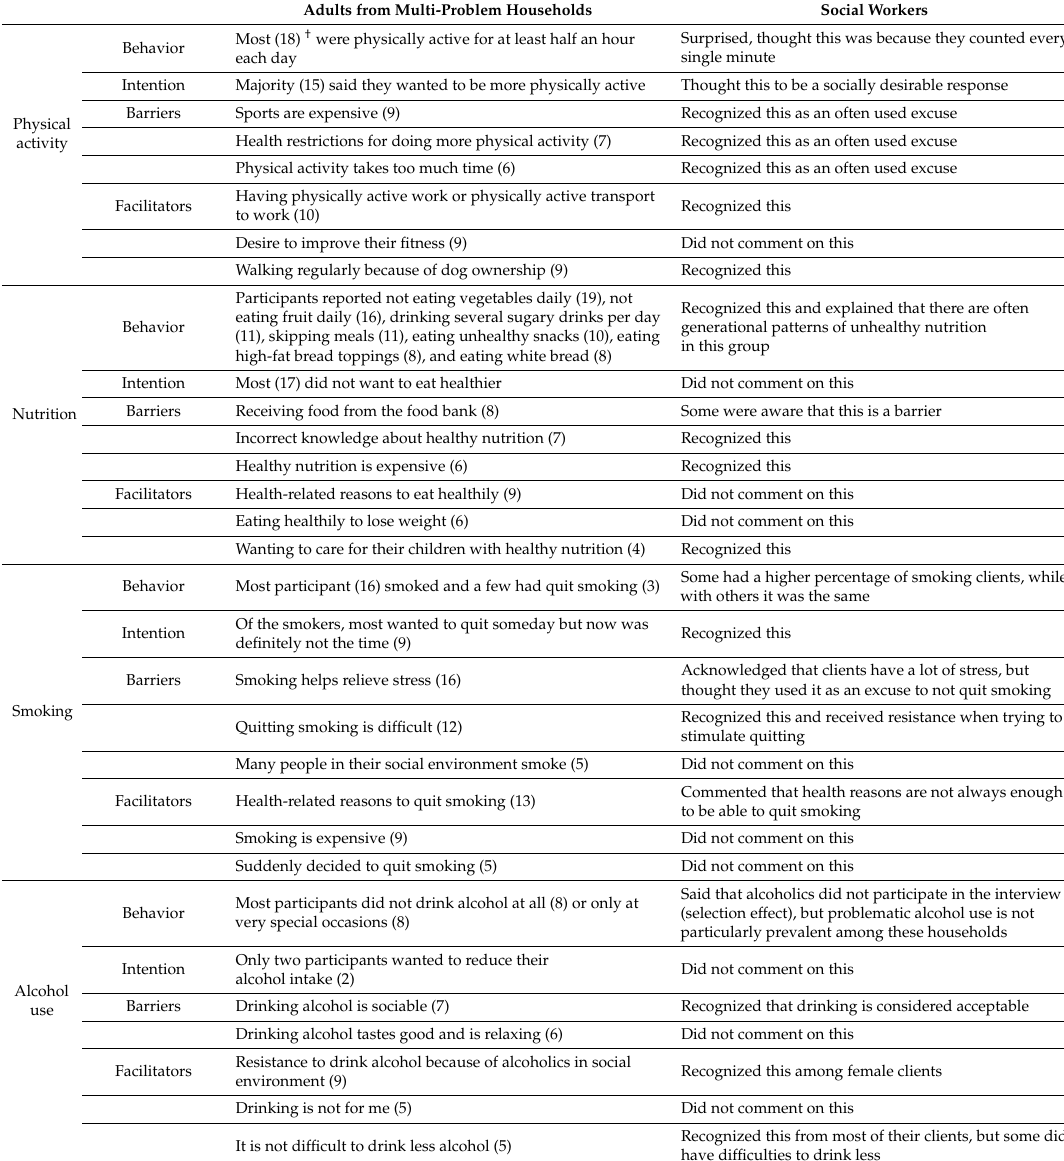
Table 3. Behavior, intention, top three barriers, and top three facilitators per health behavior according to adults from multi-problem households and responses of social